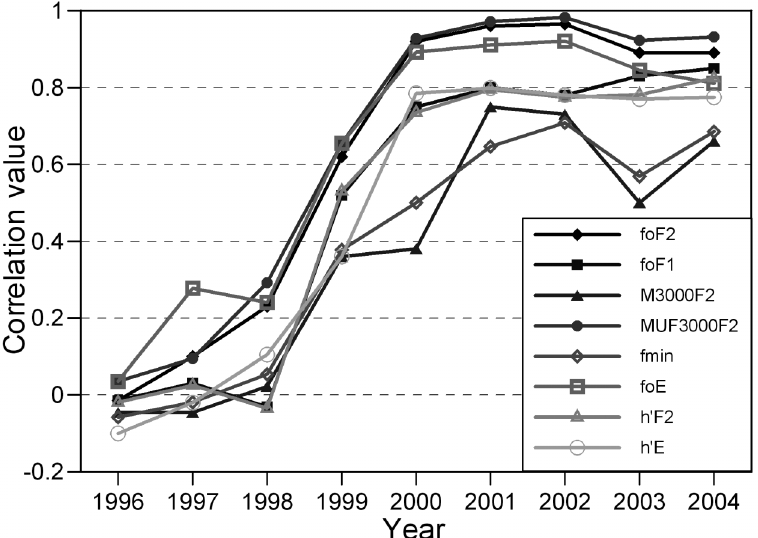
Fig. 1. Time evolution of the correlation coefficients calculated for years 1996-2004 between manually scaled and autoscaled values of the indicated ionospheric characteristics. Results are obtained for Chilton station. Adapted from Bamford et al.